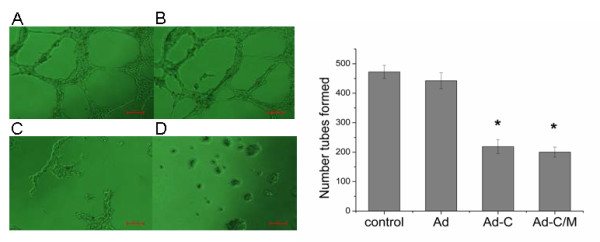
Effect of Ad-CALR/MAGE-A3 on anti-angiogenesis in vitro. Using matrigel coated 96 well plates, anti-angiogenesis ability was observed. (A) - (D): Photomicrographs showing representative views of tube formation assays. In the presence of Ad-CALR(C) or Ad-CALR/MAGE-A3(D), the number of connecting HUVEC was smaller than those of Null (A) and Ad-vector (B). Scale bars = 100 μm. (E): Bar represents the mean number of the cells per field. The tube formation assay showed that the transfection of Ad-CALR/MAGE-A3 attenuated the tube formation ability of HUVEC cells. Data are presented as mean ± SD (*P < 0.05, compared with HUVEC or HUVEC/Ad-VECTOR, P > 0.05, compared with HUVEC/Ad-CALR group).